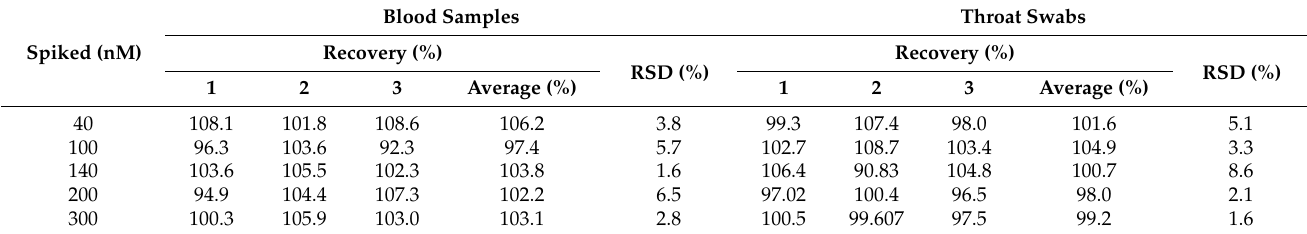
Table 2. The recovery of N protein in clinical blood and swabs sample.